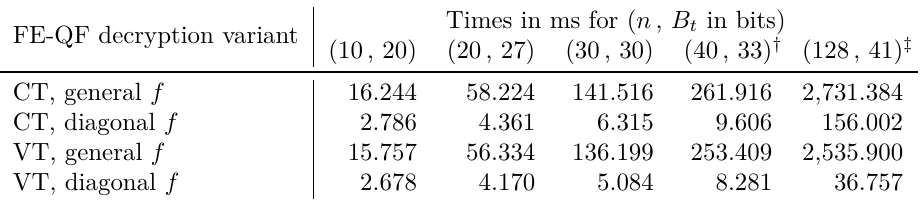
Figure 5: Timing results of the HW/SW codesign for (a) pairings and F (Alg. 1 lines 1–6) as a function of n , the length of x and y , and (b) discrete logarithm (Alg. 1 line 7) as a function of the length of the result in bits. Table 3: Timing results for functions with different parameters n and B t (in milliseconds). The VT times are calculated with uniformly random input vectors x, y and function f